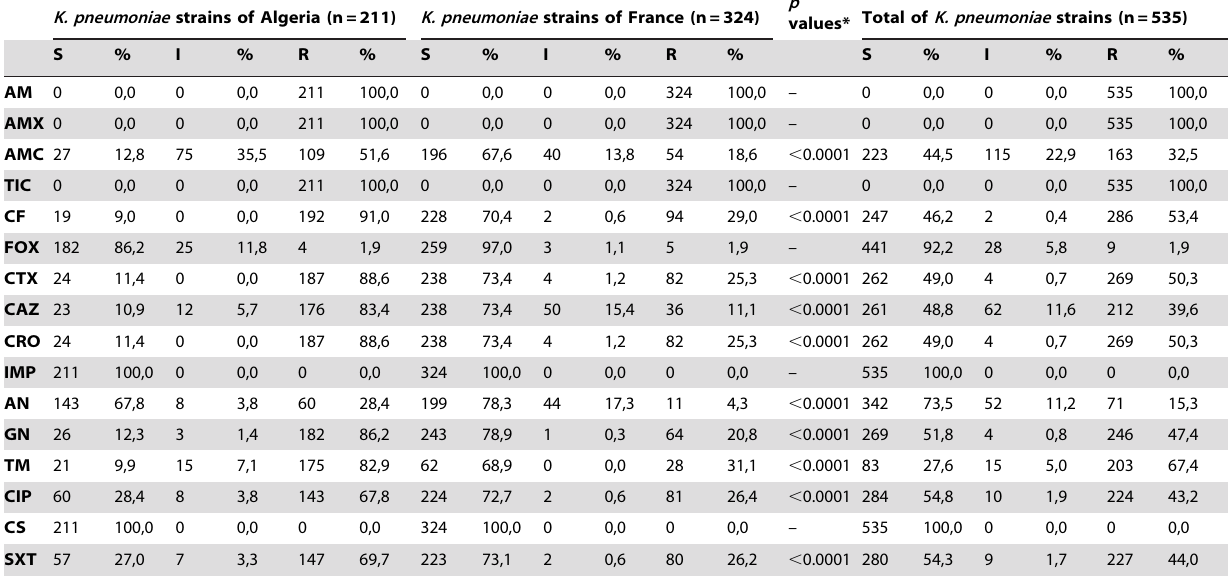
Table 2. Antibiotic susceptibility testing results of Klebsiella pneumoniae